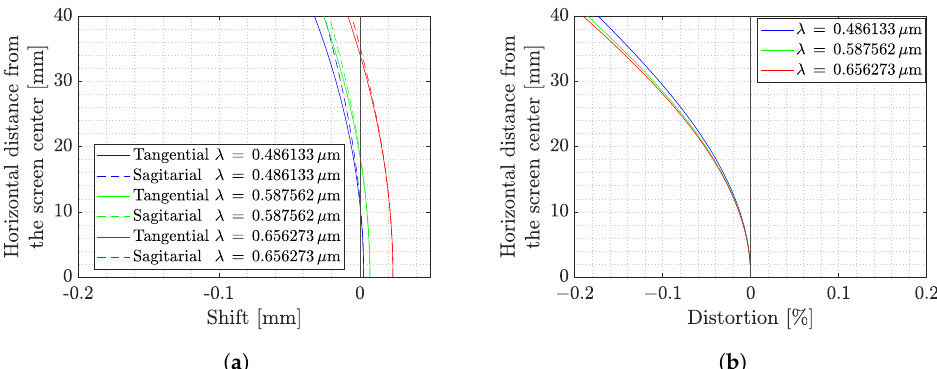
Figure 9. Field curvature and distortion analysis from Zemax ® as a function of the horizontal distance. ( a ) Field curvature on tangential and sagittal planes for different wavelengths λ . ( b ) Field distortion for different wavelength λ